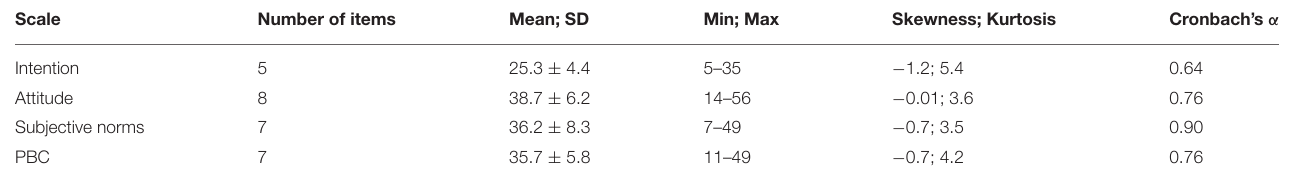
TABLE 2 | Characteristics of the